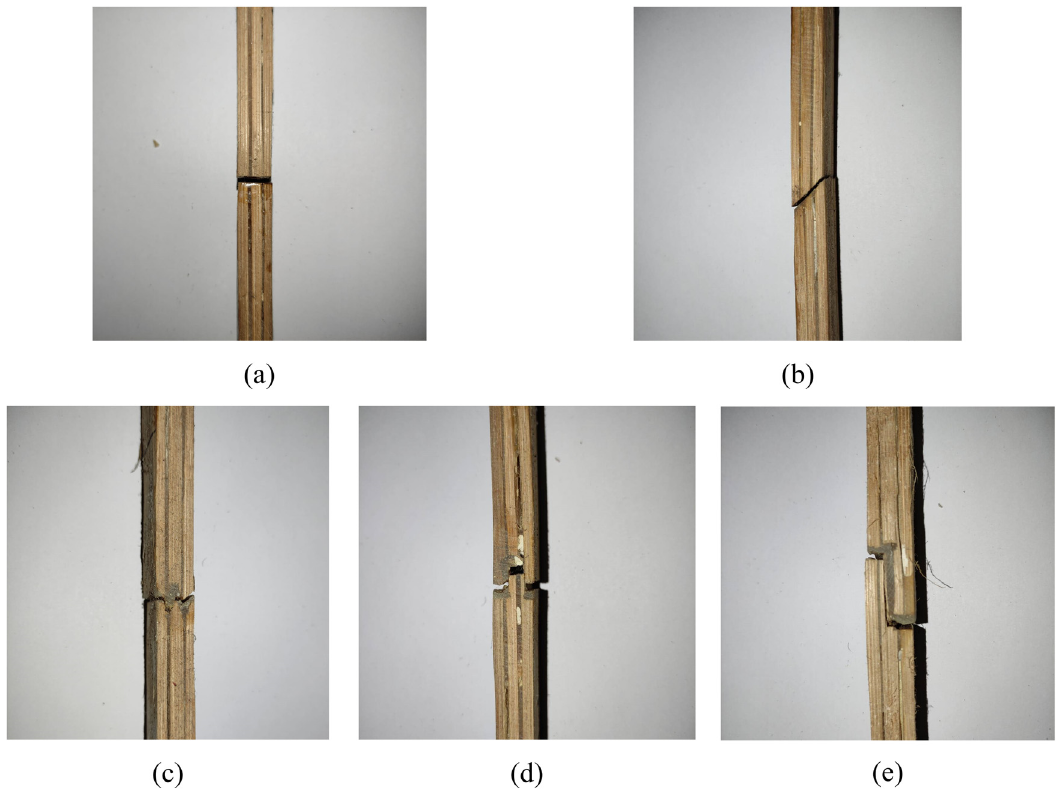
Figure 11: Macrography of tensile test specimens: ( a ) butt joint, ( b ) scarf joint, ( c ) fi nger joint, ( d ) tongue and groove joint, and ( e ) desk joint.